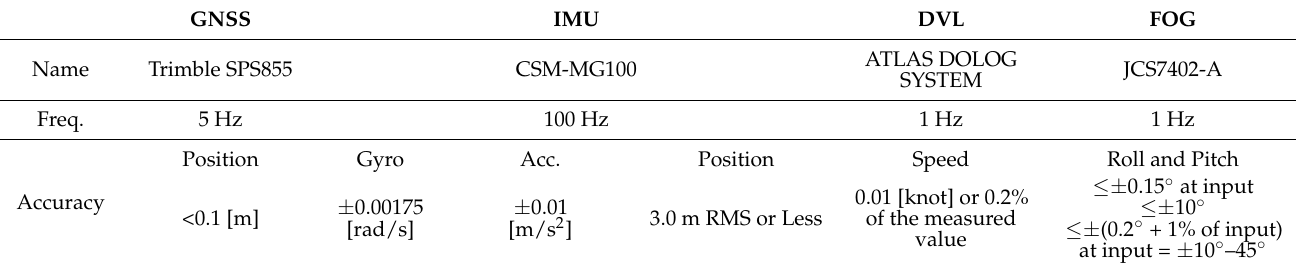
Table 2. Sensor information.